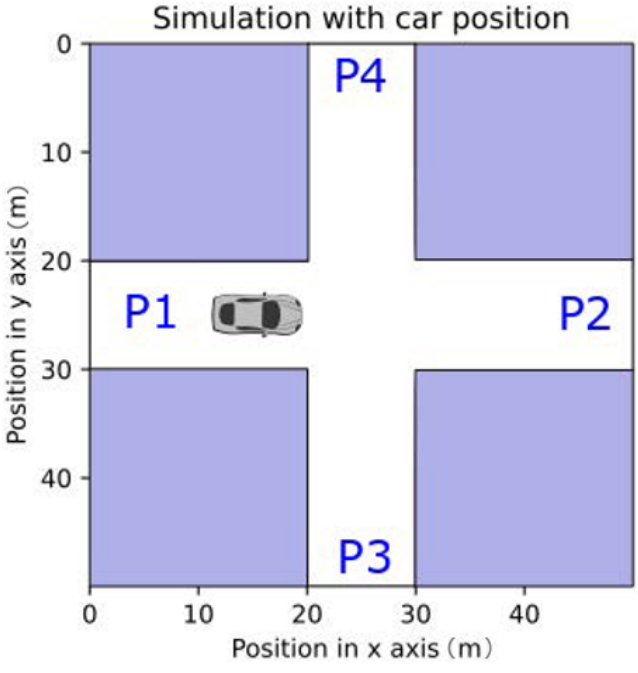
Figure 4. Simulation